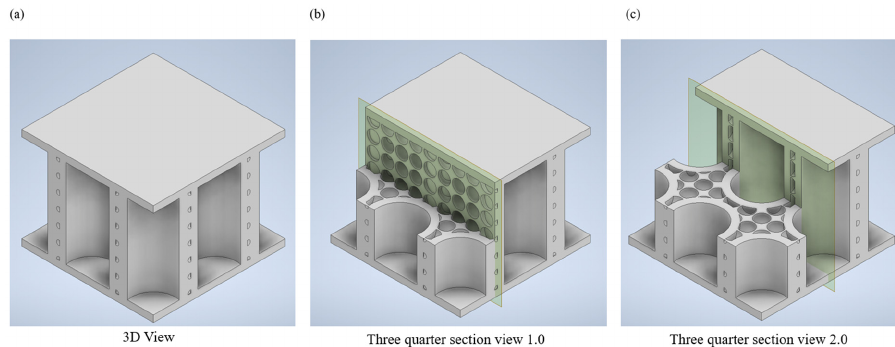
Figure 4. Two sections of interest for investigation of deformation patterns.